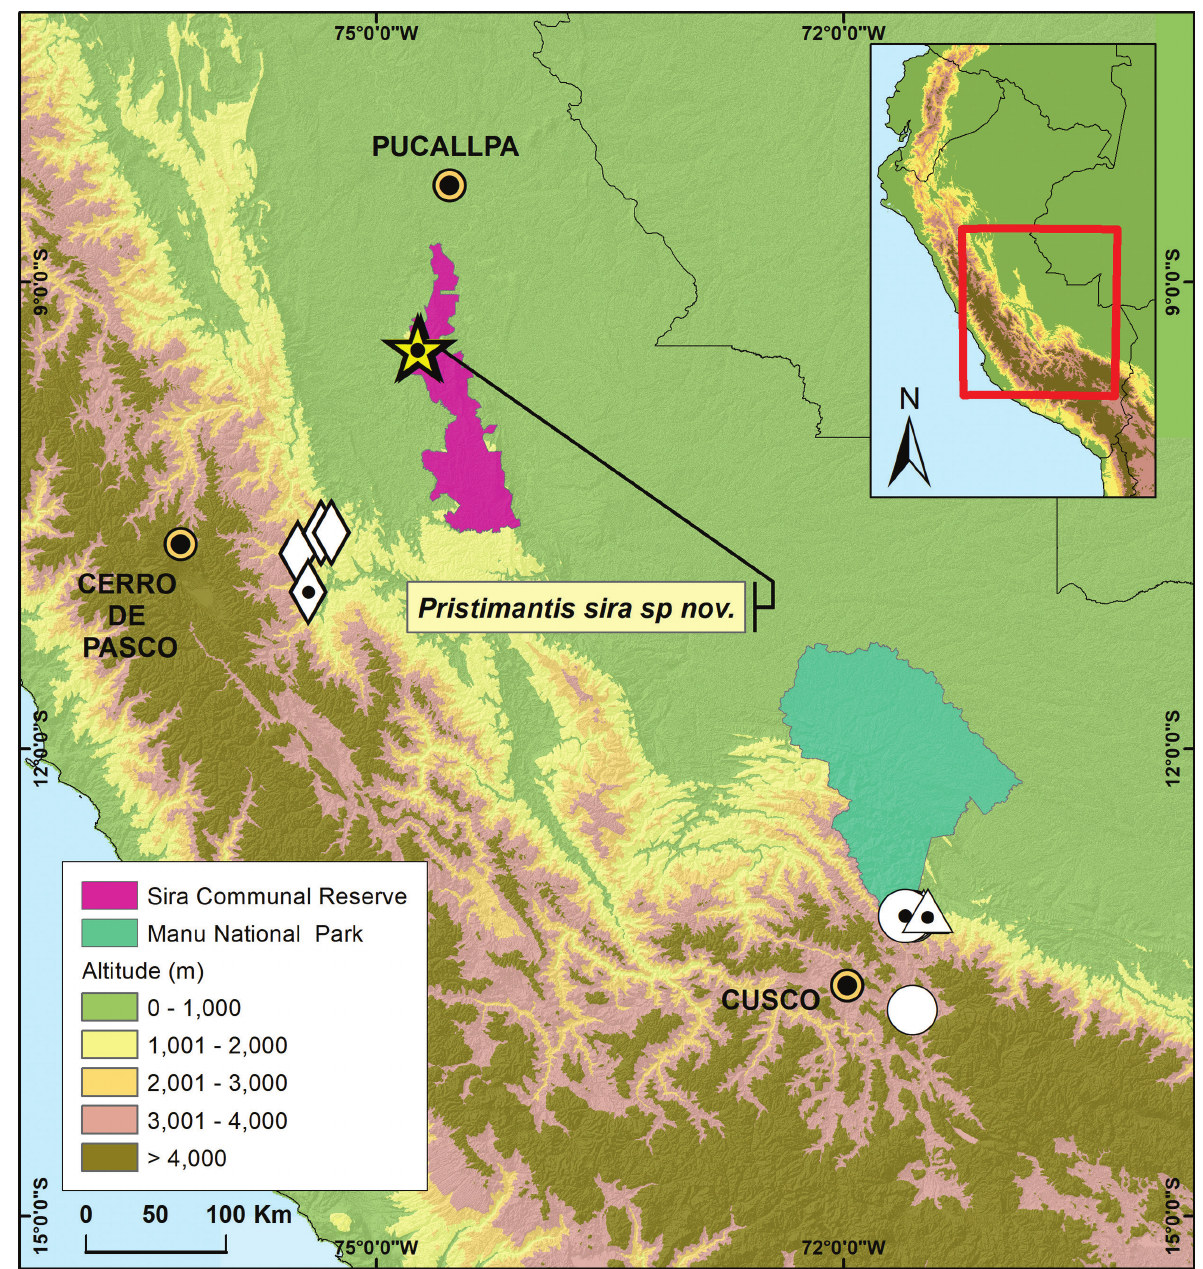
Figure 5. Map indicating the type locality of Pristimantis sira sp. nov. (yellow star), as well as type localities (symbols with a central black point) and distribution of the species of the P. cruciocularis group: P. antisuyu (white circles), P. cruciocularis (white rhomboids), P. erythroinguinis (white